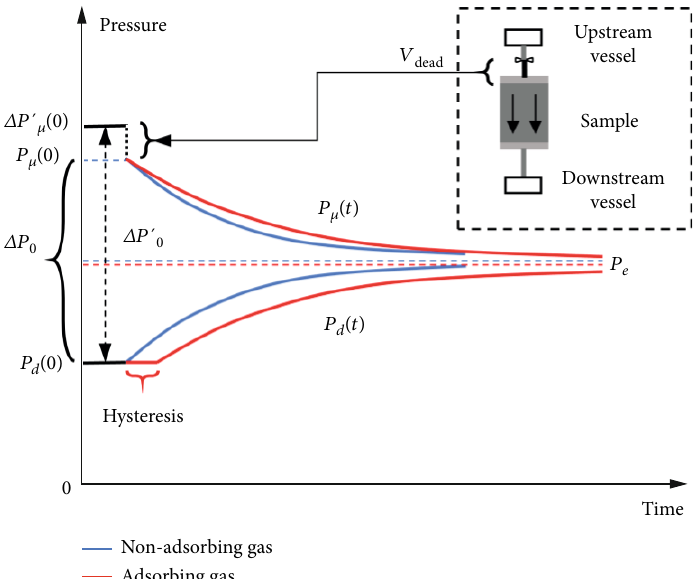
ð t Þ and P ð t Þ are the upstream u d